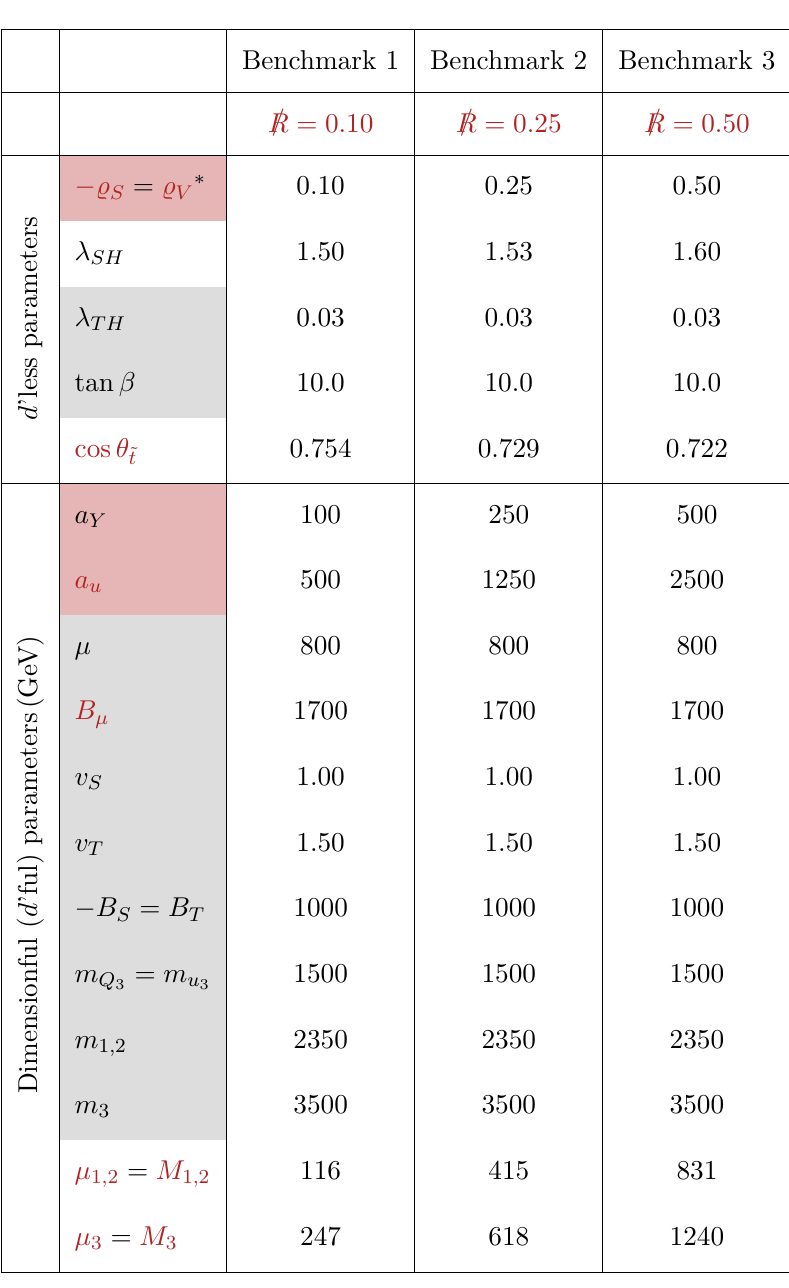
Table 2. Three benchmark scenarios for quantitative investigation of R -broken models. This table displays model parameters; see table 3 for physical masses and the relic density. Parameters typeset in red control the size of R -breaking operators, and parameters shaded in red are controlled by /R . Parameters shaded in gray are constant between